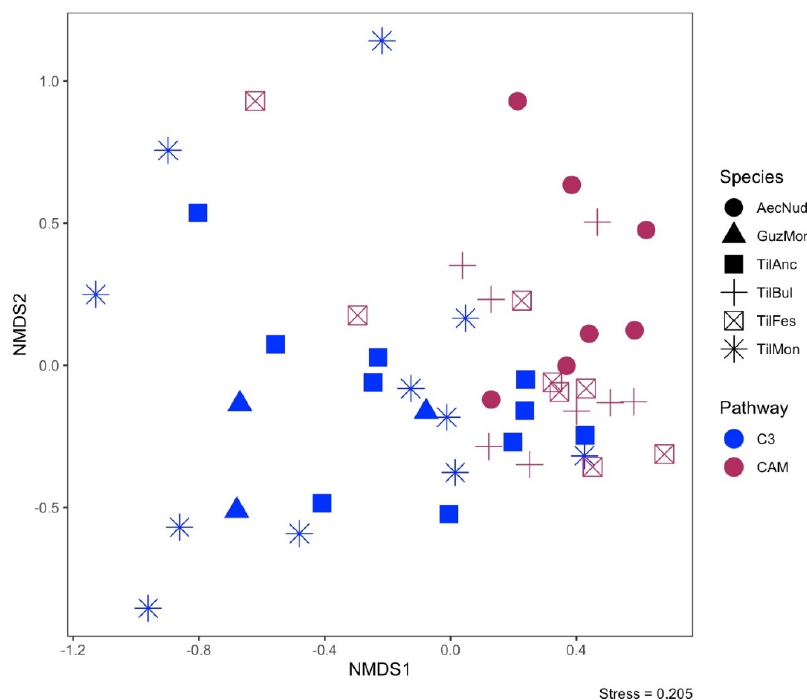
Figure 2. Nonmetric multidimensional dimensional scaling (NMDS) ordination of fungal endophyte communities among bromeliads species differing in CAM and C 3 photosynthetic pathways. Each point represents an endophyte community sampled from an individual bromeliad ( n = 47).